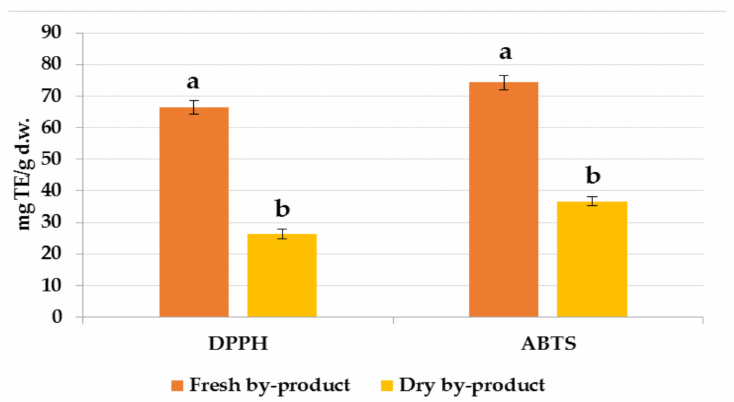
Figure 5. Comparison of antioxidant activities by two methods (DPPH and ABTS) in fresh and dry orange by-products extracts expressed in mg TE/g d.w. Different letters reported statistical significant